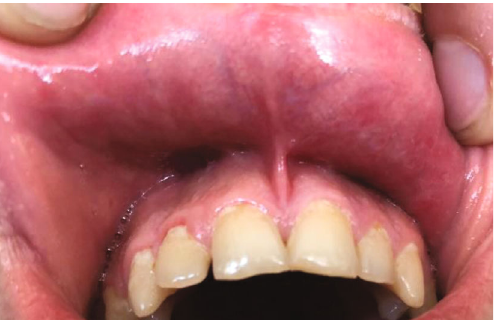
Figure 3: The mucous membrane of the lip with resolution of aphthous